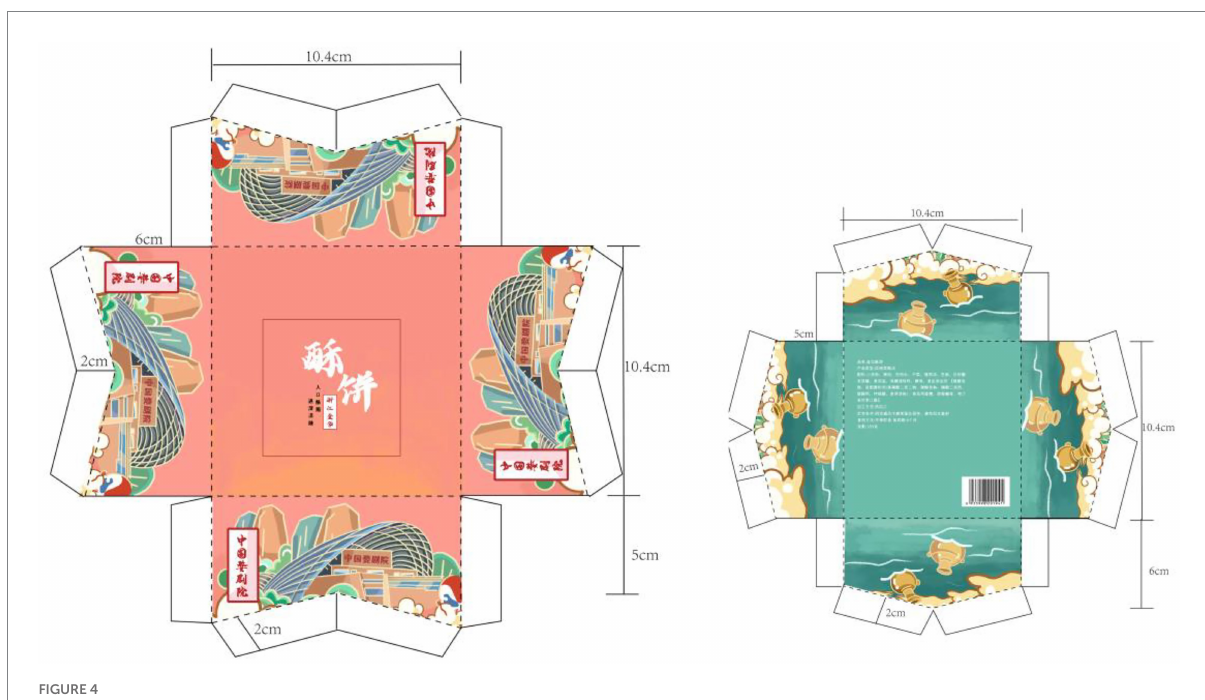
FIGURE 4 Shortbread packaging